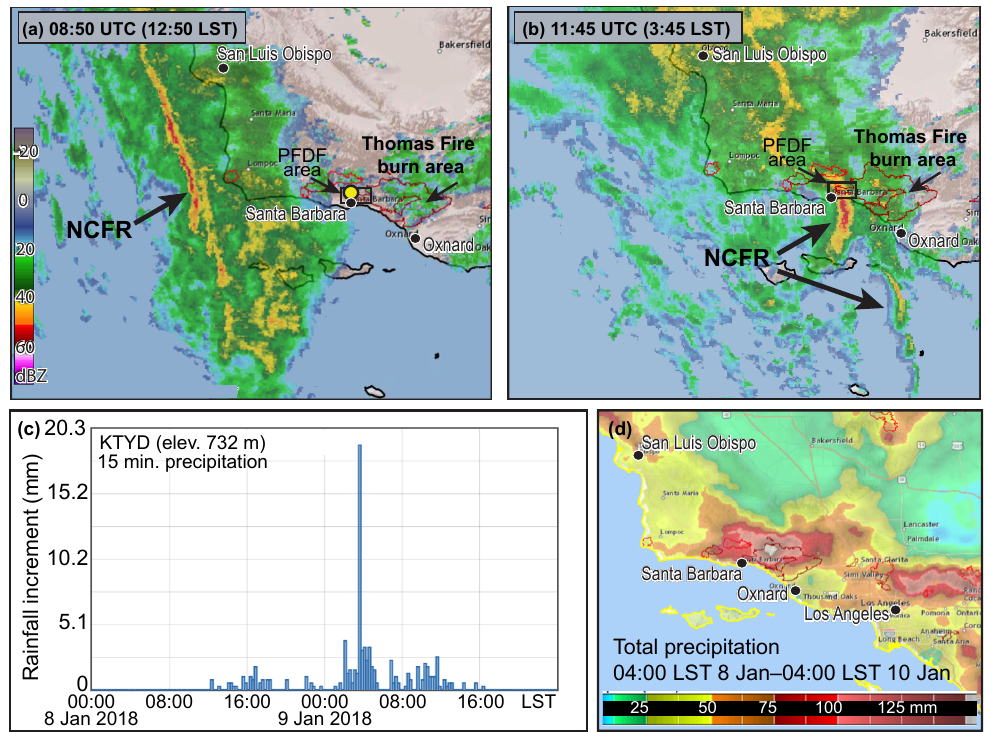
Figure 4. Panels (a) and (b) show radar imagery (a) preceding and (b) at the time of PFDFs on the Thomas Fire burn area. Yellow to red colors indicate higher-intensity precipitation. Radar image source: California Nevada River Forecast Center (CNRFC; https://cnrfc.noaa.gov/, last access: 5 November 2018). Panel (c) shows precipitation observations at 15min intervals from the KTYD station operated by SBCPWD. The station position is indicated by the yellow marker in panel (a) . Panel (d) provides regional 48h precipitation totals from